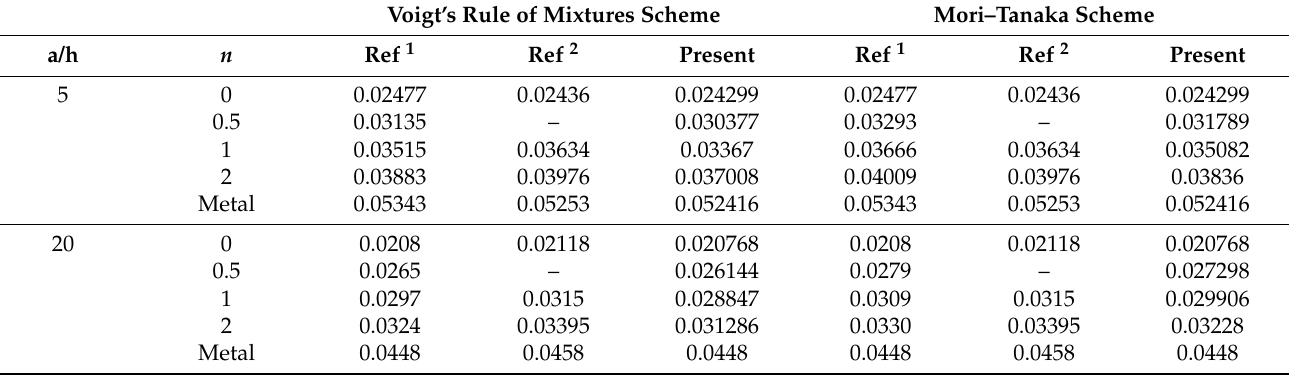
Table 5. Non-dimensional central deflection (w 3 ) of the simply supported square FGM plate effective elastic properties computed by Voigt’s rule of mixtures and Mori–Tanaka scheme. Voigt’s Rule of Mixtures